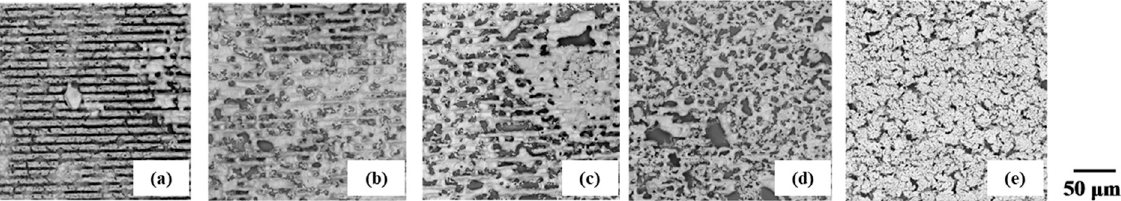
Figure 9. SEM images of sintered CuO–NiO NP micropatterns at different scanning speeds: ( a ) 0.1; ( b ) 0.5; ( c ) 1; ( d ) 3; ( e ) 5 mm/s [154].